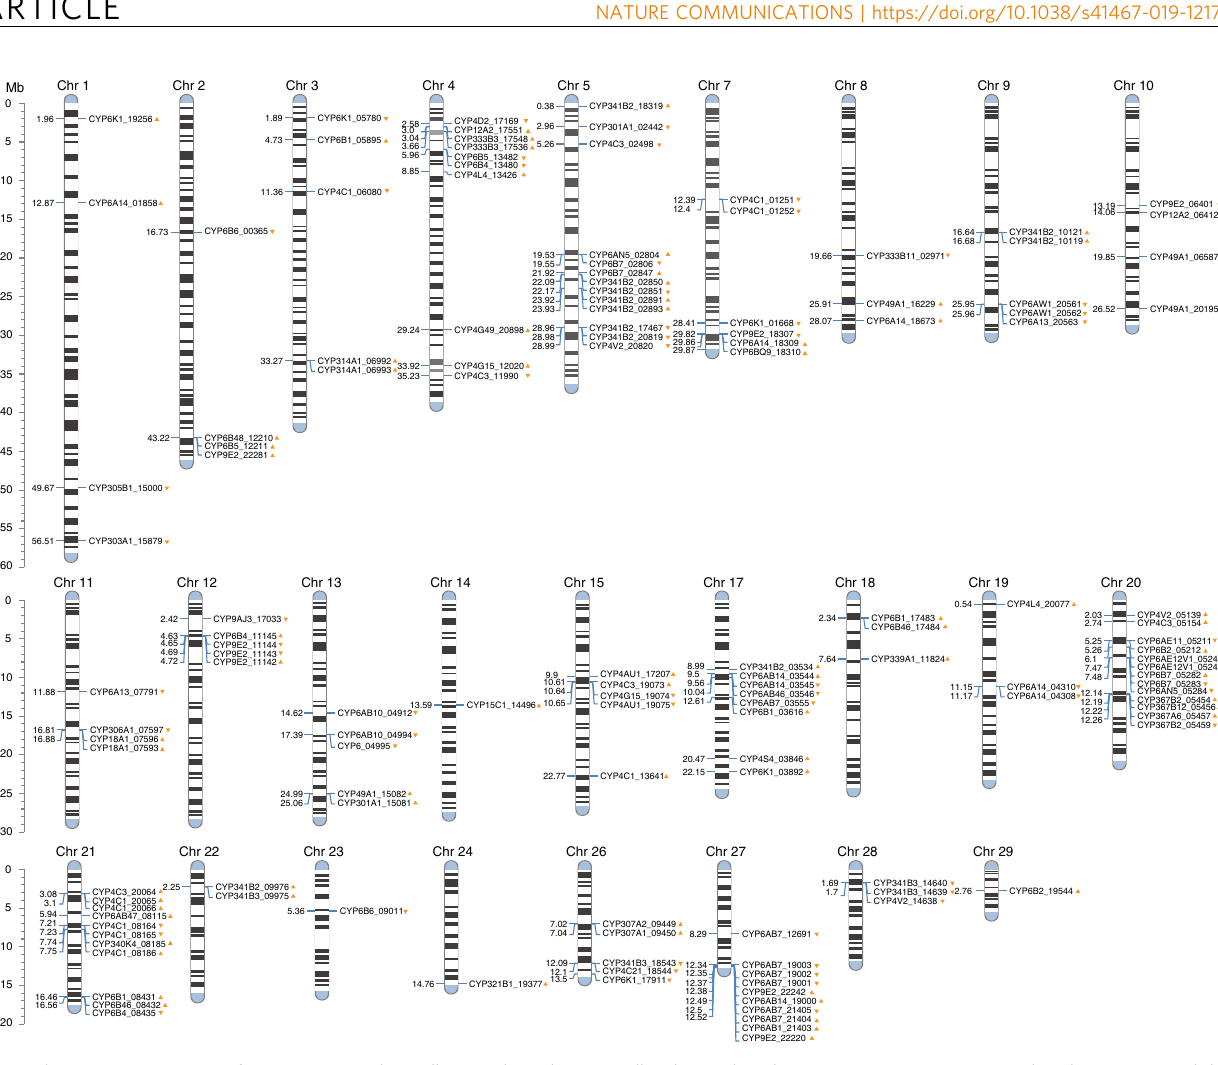
Fig. 5 The genomic positions of P450 genes in the codling moth, Cydia pomonella . The predicted 146 P450 genes were mapped to the genome and the 5 ’ UTR of 69 P450 were successfully ampli fi ed with RACE strategy. The distribution analysis of all 146 P450 genes showed that there are 16 gene clusters which have three or more P450